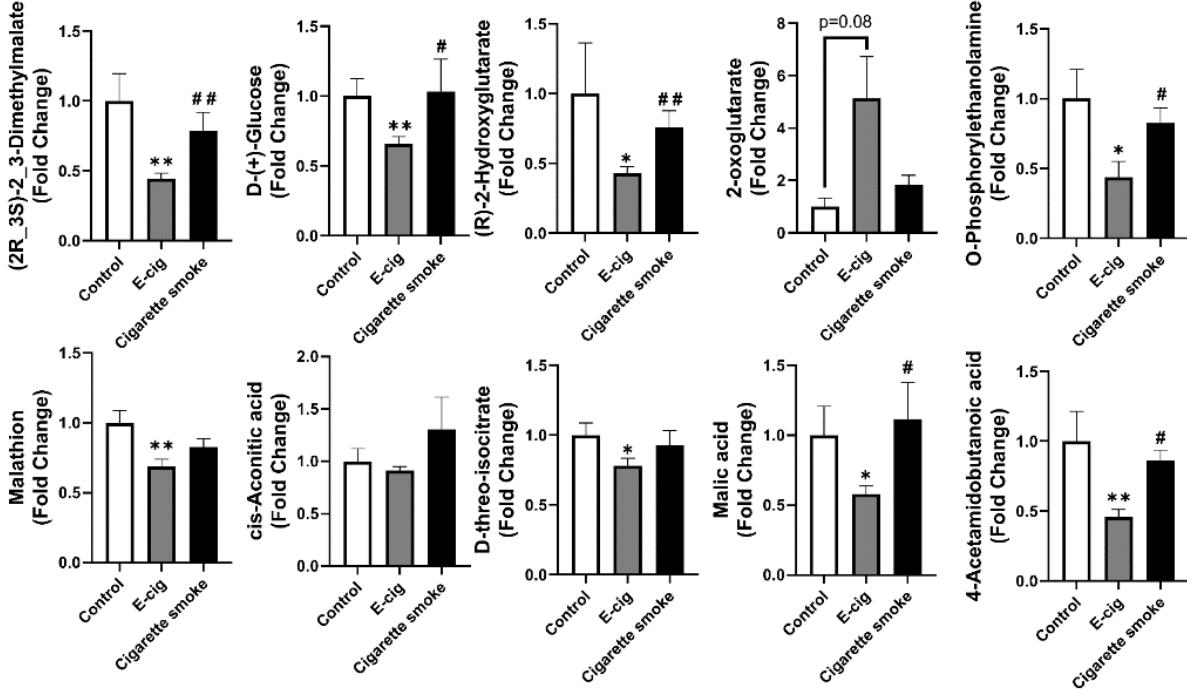
Figure 4. Metabolites from plasma analyzed from UPLC-MS from negative ion mode identified dysregulated TCA cycle related metabolites in e-cig users. Fold changes were calculated based on the normalized area from UPLC-MS spectra, and control groups were used as a baseline. Data are shown as mean ± SEM ( n = 6 for non-smoking control and cigarette smoke groups, n = 12 for e-cig group; * p < 0.05, ** p < 0.01 vs. non-smoking control; # p < 0.05, ## p < 0.01 vs. e-cig).